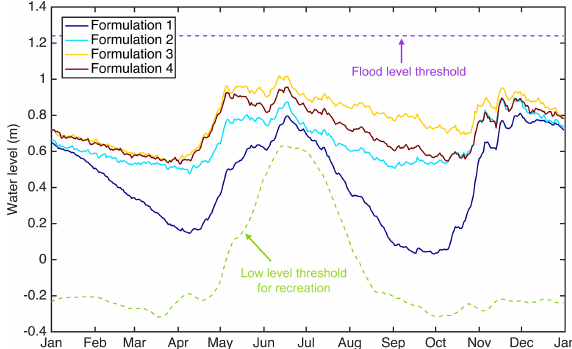
Figure 7. Trajectories of the average lake level for the best equitable solution in each problem